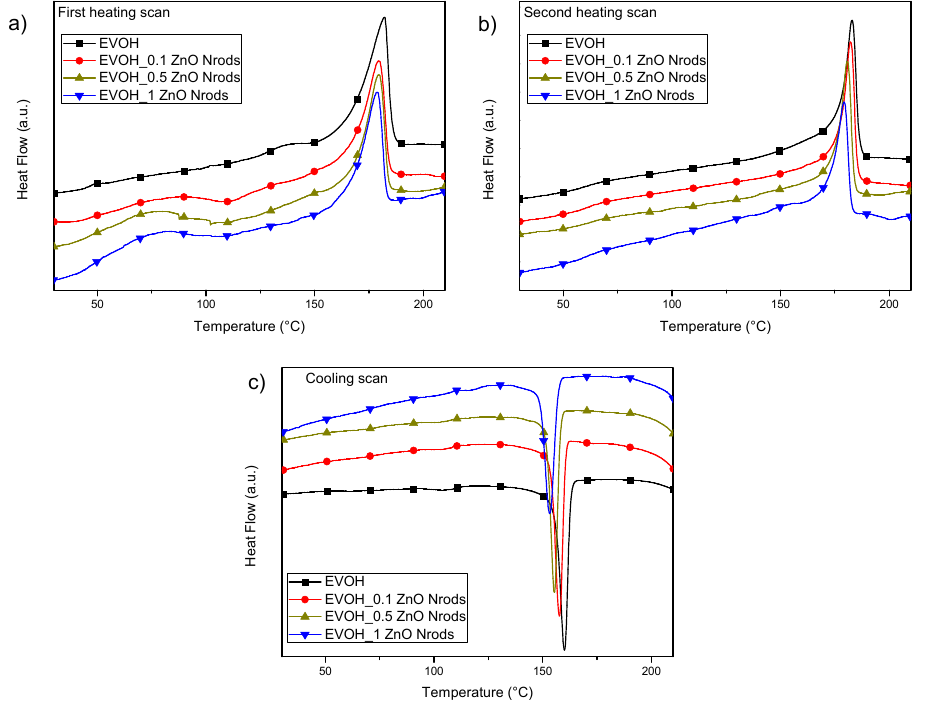
Figure 6. DSC thermograms of EVOH-based formulations at first heating scan ( a ), cooling scan ( b ) and second heating scan ( c ).